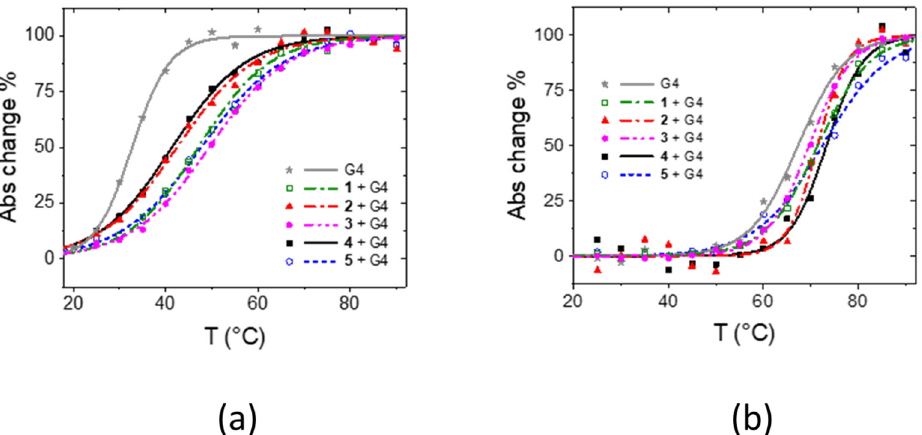
Figure 2. Melting plots for the ligand/G4 systems studied ( λ = 295 nm). ( a ) Tel12 ([ligand] = 1.75 × 10 − 5 M, [Tel12] = 1.87 × 10 − 5 M); ( b ) Tel23 ([ligand] = 1.40 × 10 − 5 M, [Tel23] = 1.38 × 10 − 5 M); KCl 0.1 M, NaCac 2.5 mM, pH 7.0. The lines correspond to the sigmoidal fits of the experimental trends, whose inflection points correspond to T m .